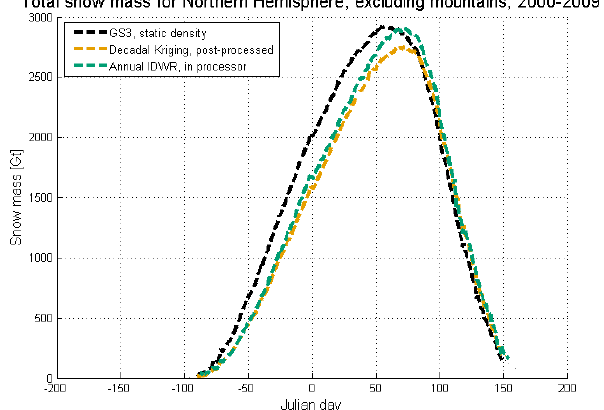
Figure 9. The total Northern Hemisphere snow mass (without mountains) calculated from GSv3.0 and dynamic densities in re- trieval products for